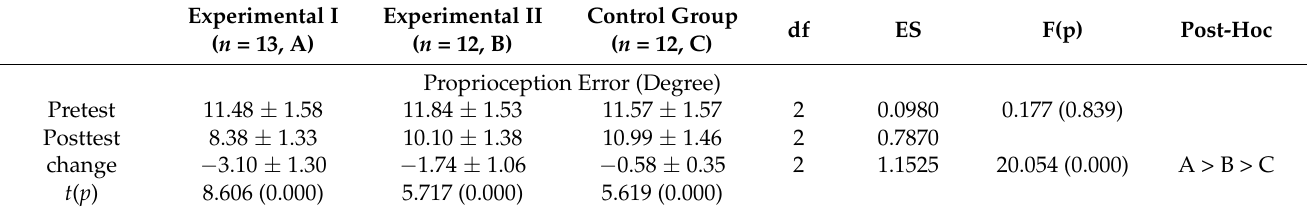
Table 3. Comparison of proprioception error among the three